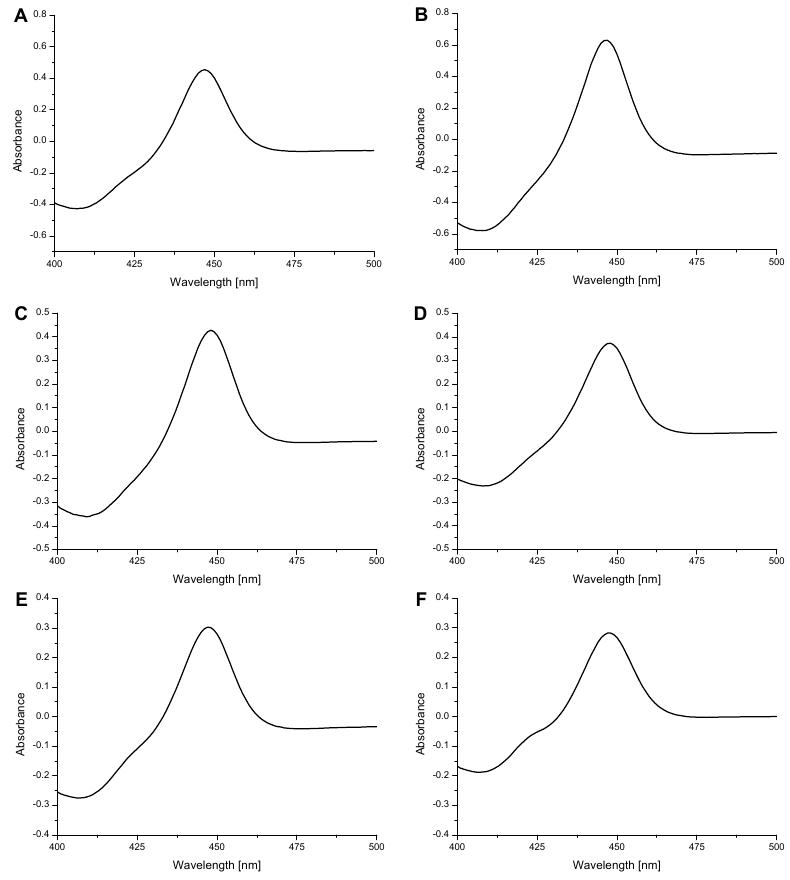
Figure 3. The CO-spectra of purified human CYP1A1 ( A ); its mutant S122A ( B ); CYP1A2 ( C ); its mutant T124V ( D ); CYP1B1 ( E ) and its mutant A133S ( F ). Fe 2+ -CO versus Fe 2+ difference spectra.